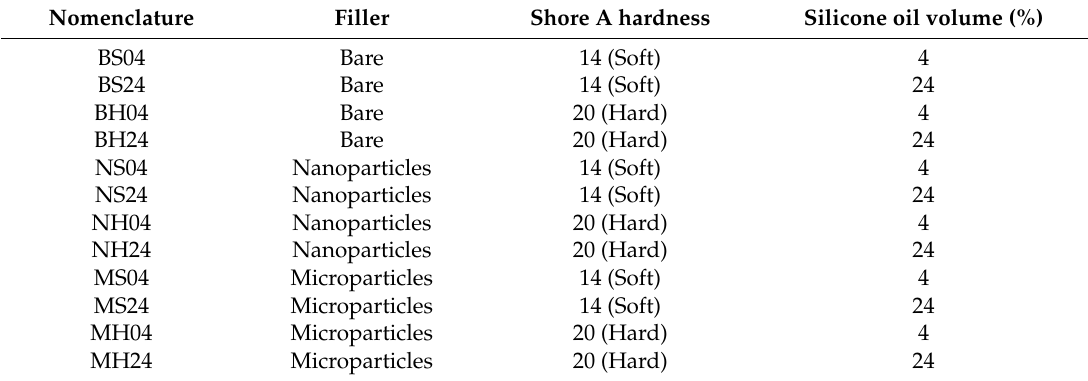
Table 1. Nomenclature definition of magnetorheological elastomer (MRE) samples.